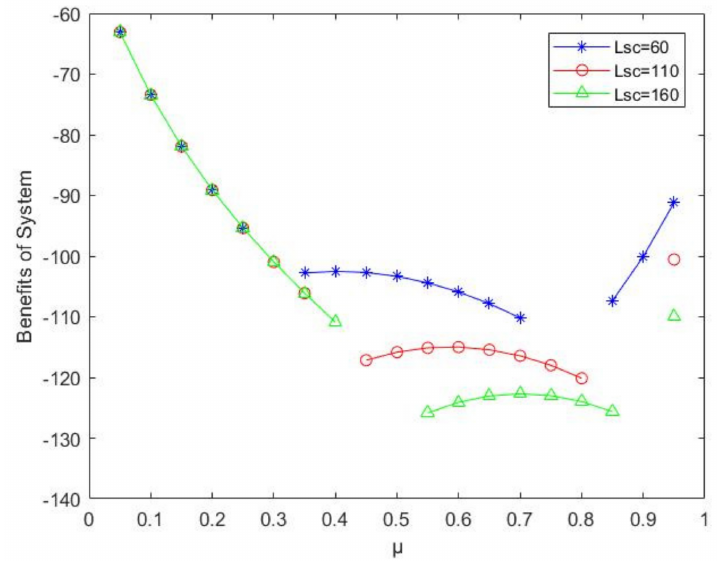
Figure 7. System Incomes under Changes in µ and L SC.